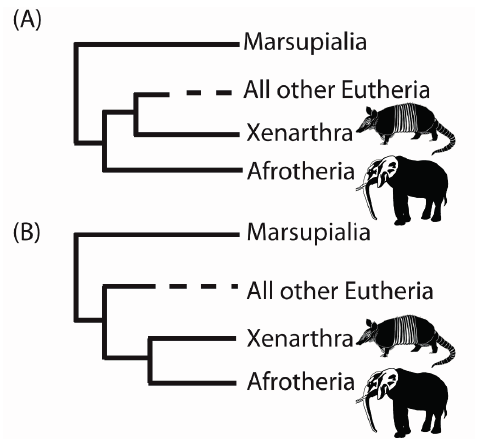
Figure 6. Analysis of the position of the mammal root using three different methods. ( A ) Afrotheria position retrieved using RomiguierTopAT alignment and the GTR model in RAxML (result = Afrotheria position for the root), and also using the optimum available P4 model; and ( B ) Atlantogenata position retrieved using the 39 taxa mammal dataset from Morgan et al. [7] with the CAT-GTR model in